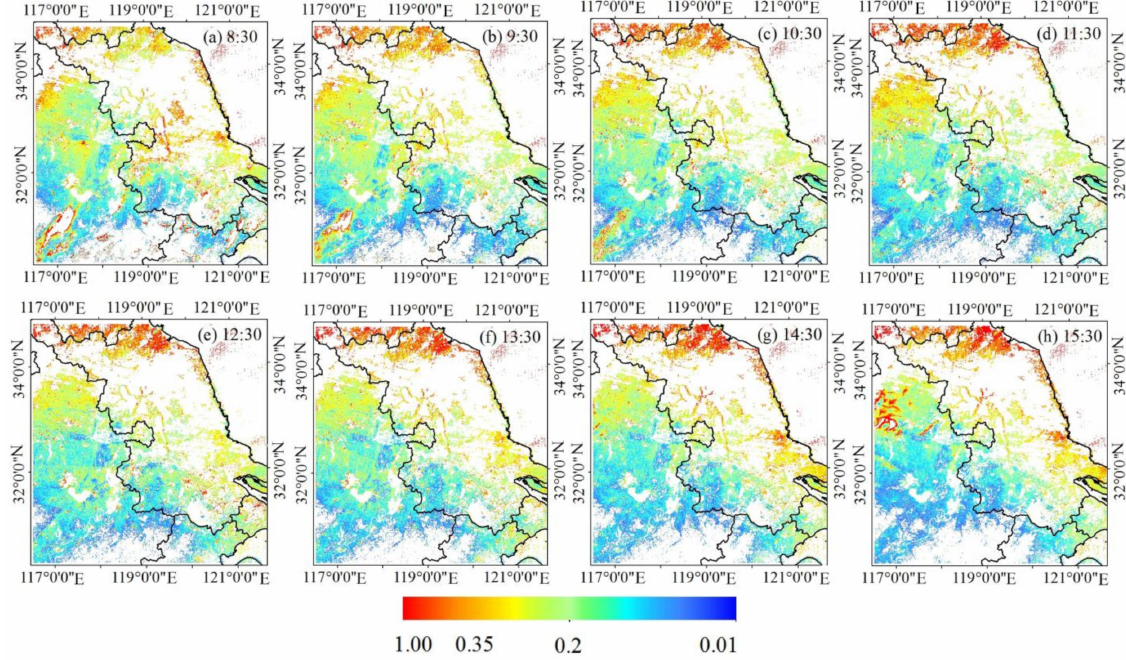
Figure 5. GOCI AOD retrieval results at 550 nm on 23 February 2018. (( a – h ) are the results of image retrieval with an interval of 8:30 a.m.–15:30 p.m.,